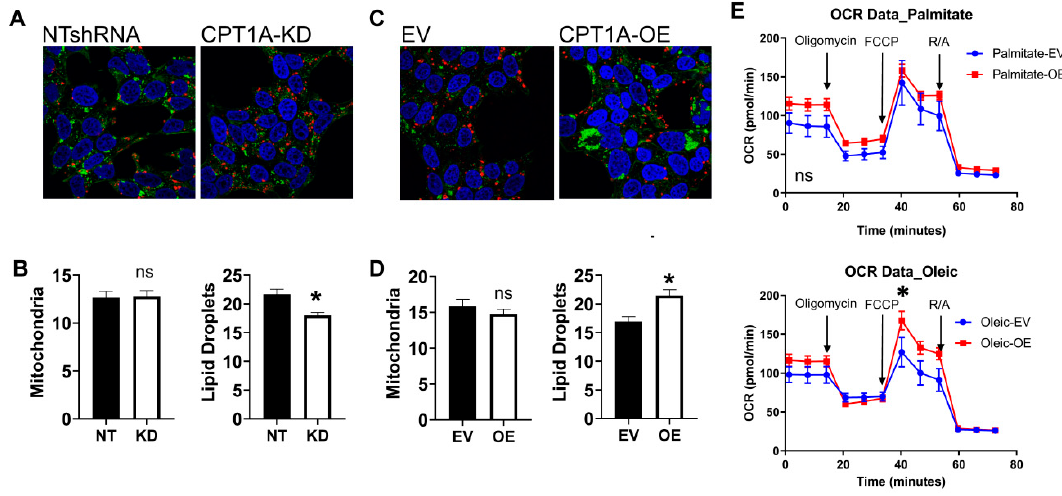
Figure 2. Phenotypic characterization of C4-2 CPT1A -KD and CPT1A -OE cells. ( A – D ): Mitochondrial and lipid droplet staining in CPT1A -KD cells ( A – B ) and CPT1A -OE cells ( C – D ). Cells were stained for lipid droplets (green), mitochondria (red), and nuclei (blue). A minimum of 20 cells per group were captured and quantitated using ImageJ. * p < 0.01 vs. control. ( E ): Oxygen Consumption Rate (OCR) of C4-2 CPT1A -OE and control EV cells (n = 10 each) was measured using the Seahorse XFe96 Analyzer. Cells were serum-starved overnight and then incubated with the BSA-conjugated fatty acids (palmitate or oleate) 1 h before the assay. Traces shown correspond to Cell Mito Stress protocol, using Oligomycin (2 uM), FCCP (2 um) and rotenone/antimycin A (1 uM) at 20, 40, and 60 min respectively, p * = 0.012 compared with EV control. Seahorse graphs show mean ± SEM.